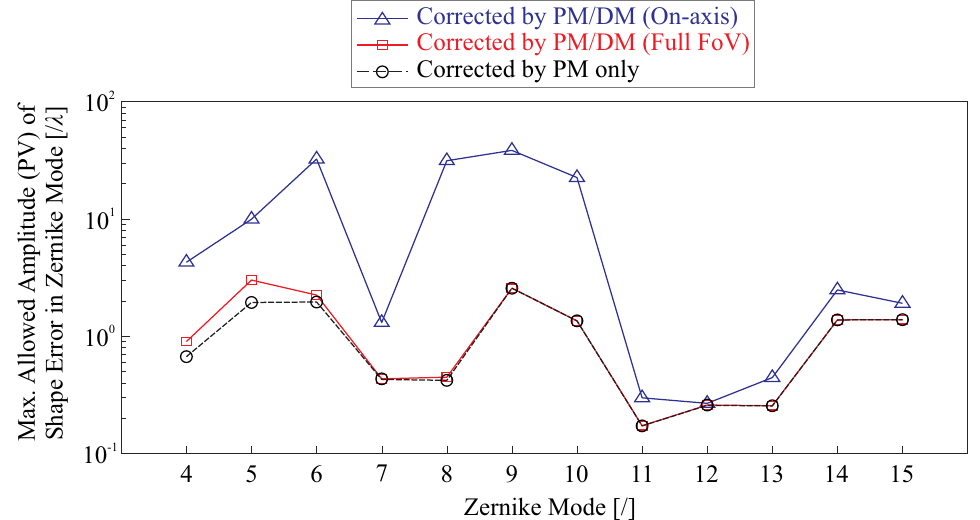
Figure 15. Maximum allowed amplitudes of surface errors (in λ ) for different